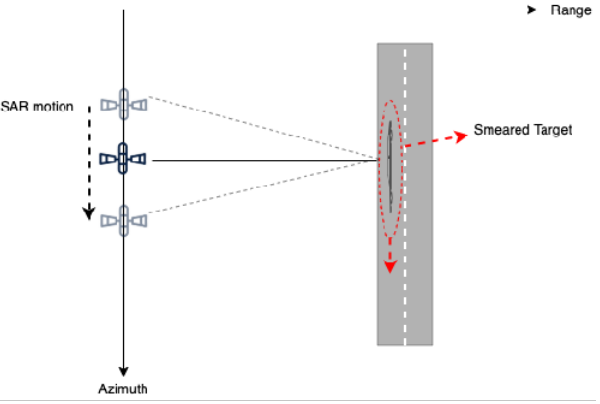
Figure 4. Smearing effect in along-track motion of vehicles.